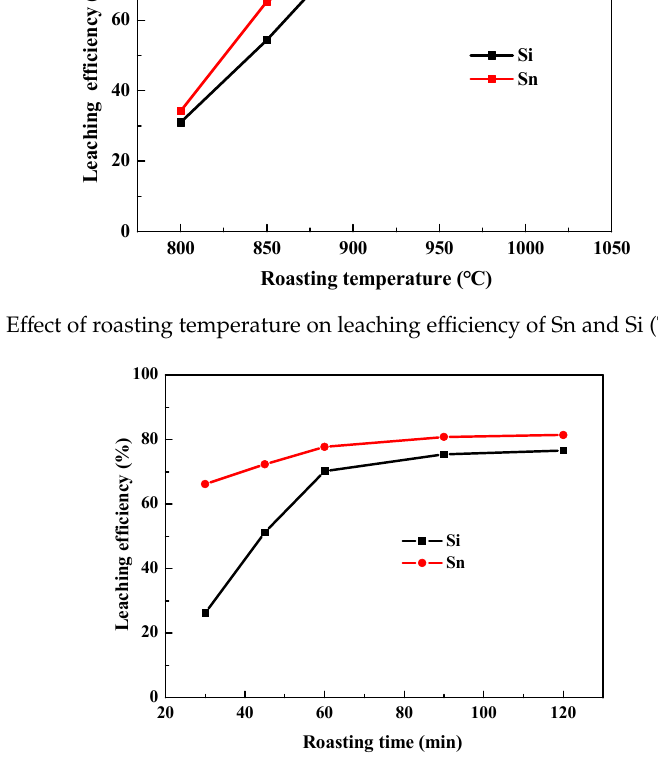
Figure 2. Effect of roasting time on leaching efficiency of Sn and Si (Temperature: 875 °C). Figure 2. E ff ect of roasting time on leaching e ffi ciency of Sn and Si (Temperature: 875 ◦